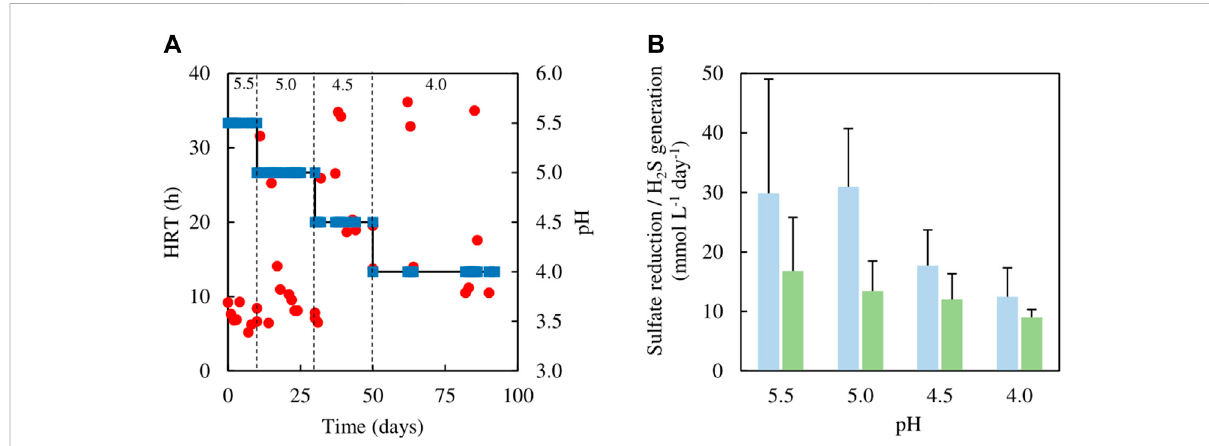
FIGURE 8 (A) ChangesinHRTs( C )atdifferentoperationalpHvalues( ■ )ofthesul fi dogenicbioreactorfedwithethanolalone(equivalentto8 mM),and (B) variations in rates of sulfate reduction (dark green bars) and hydrogen sul fi de generation (light green bars) in each bioreactor pH tested ( n = 12). Samples were not analysed in the intervals between days 50 – 62 and days 64 – 82.